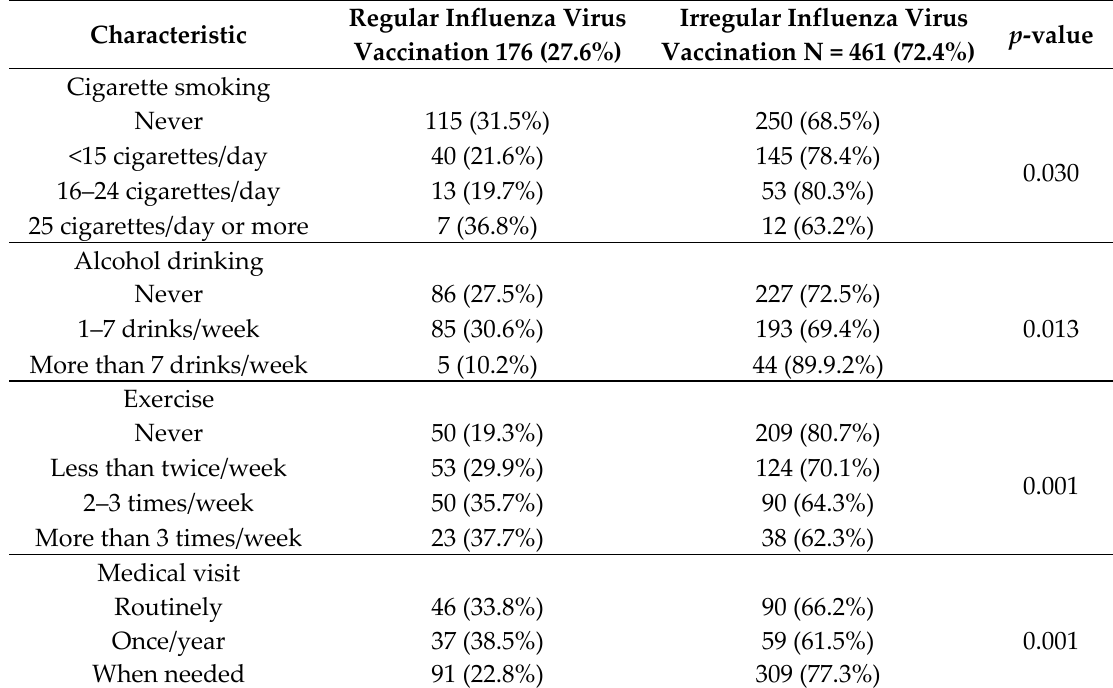
Table 2. Lifestyle characteristics and influenza vaccination.